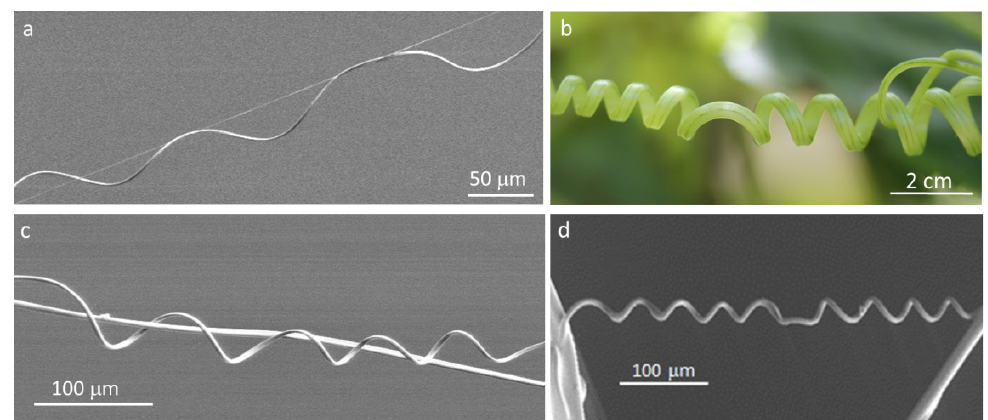
Figure 1. Helical shapes and perversions in biological systems: ( a ) fibers of spider webs (photo of spider silk produced by an unidentified spider); ( b ) cucumber tendril helices; ( c ) and ( d ) cellulose fibers electrospun from liquid crystalline